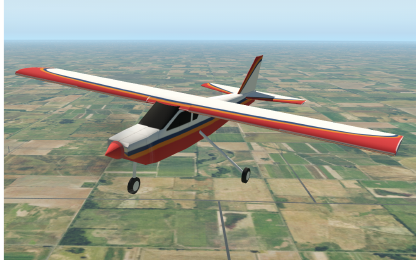
Figure 8. The X-Plane flight model of the Avistar